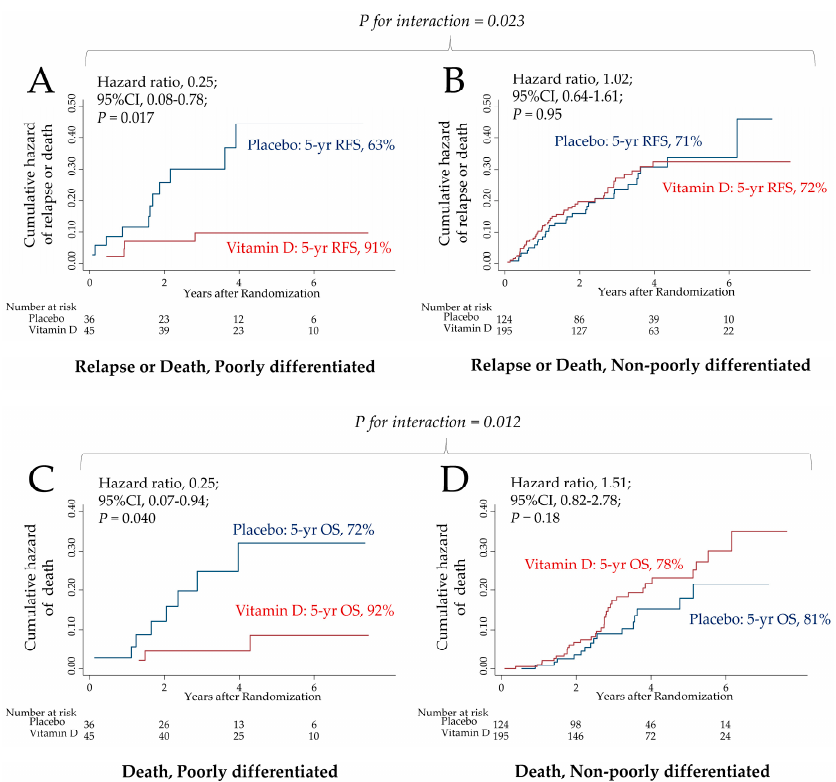
Figure 2. Effect of vitamin D supplementation on risk of relapse or death and risk of death: Poorly differentiated vs. non-poorly differentiated. Cumulative hazard curves between vitamin D or placebo were compared ( A ) for relapse or death in the poorly differentiated subgroup, ( B ) for relapse or death in the non-poorly differentiated subgroup, ( C ) for death in the poorly differentiated subgroup, and ( D ) for death in the non-poorly differentiated subgroup. P value was determined using a Cox proportional hazards model. P for interaction between the assigned intervention (vitamin D or placebo) and the histopathological subgroups (poorly differentiated or non-poorly differentiated) was tested based on a Cox regression model. CI, confidence interval.